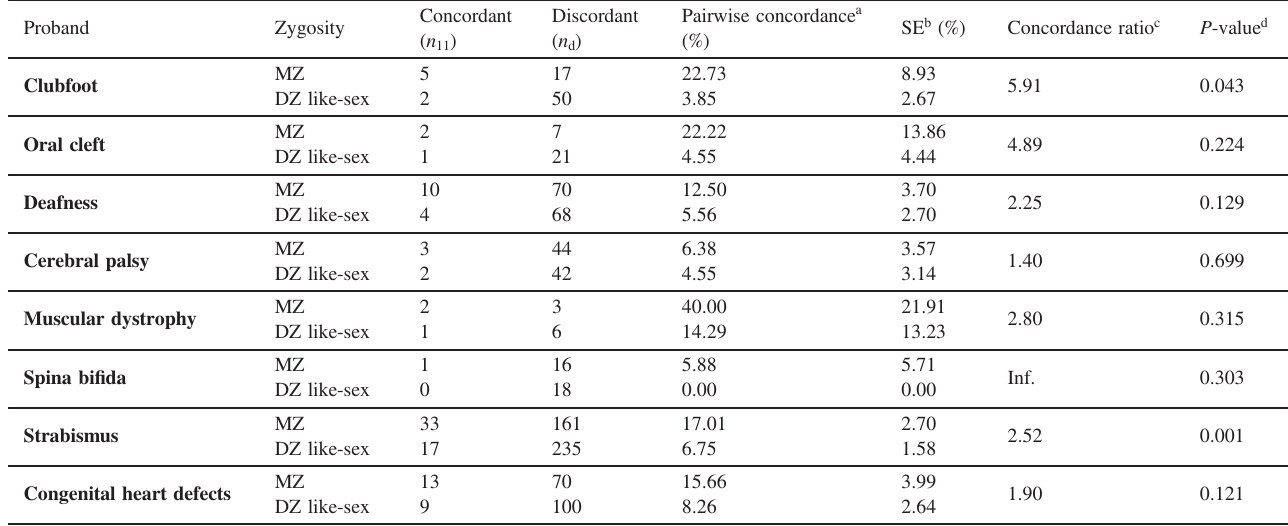
Table 3. Pairwise Concordance Ratio between monozygotic twins (MZ, N = 6,752 pairs) and dizygotic like-sex twins (DZ like-sex, N = 7,326 pairs) for each birth anomaly in the California Twin Program (Birth cohort 1957 – 1982)